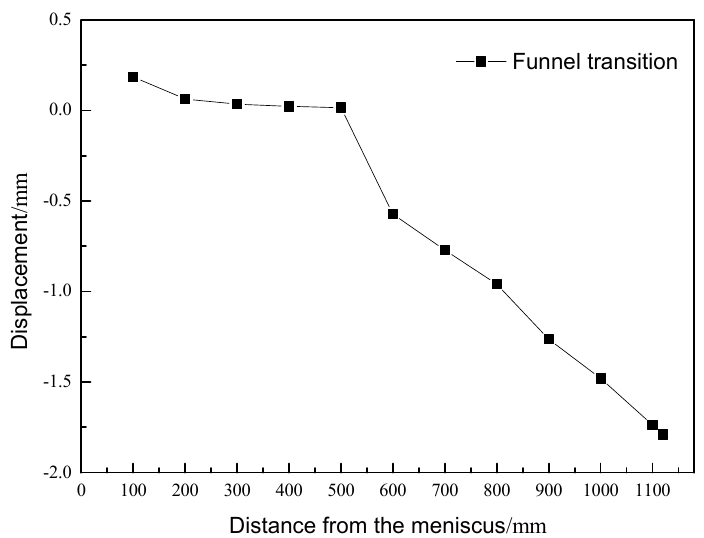
Figure 8. Variation rule of lateral displacement of shell surface in funnel transition zone.